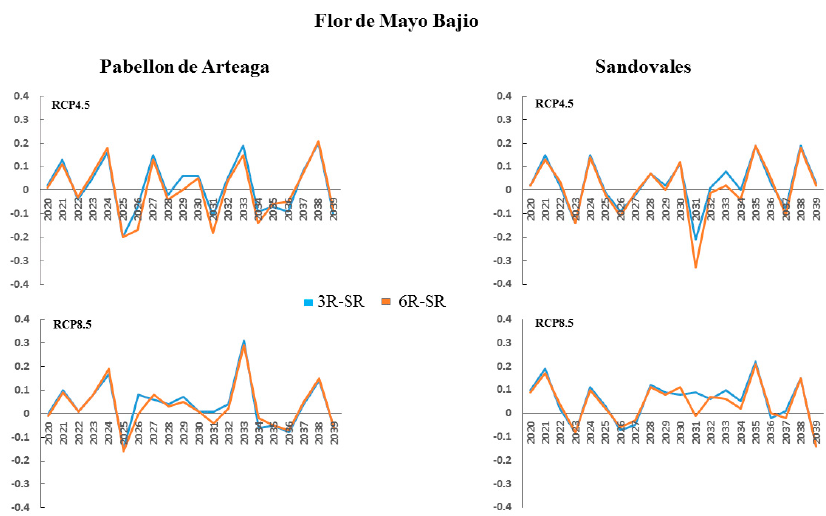
Figure 4. Forecasted seed yield (Mg ha − 1 ) increase or decrease for 2020–2039 under climatic scenarios RCP4.5 and RCP8.5 for rainfed Flor de Mayo Bajio common beans cultivar (growth habit III) under sowing densities of 145,000 (3R) and 260,000 (6R) plants ha − 1 compared to the baseline sowing density 90,000 plants ha − 1 (SR) in the semi-arid temperate highlands of Pabellon de Arteaga and Sandovales in Aguascalientes, Mexico. Table 5. Forecasted seed yield increments for 2020–2039 under climatic scenarios RCP4.5 and RCP8.5 for three common bean cultivars under sowing densities of 145,000 (3R) and 260,000 (6R) plants ha − 1 compared to a baseline sowing density of 90,000 plants ha − 1 under rainfed conditions in the semi-arid temperate highlands of Pabellon de Arteaga and Sandovales in Aguascalientes, Mexico.